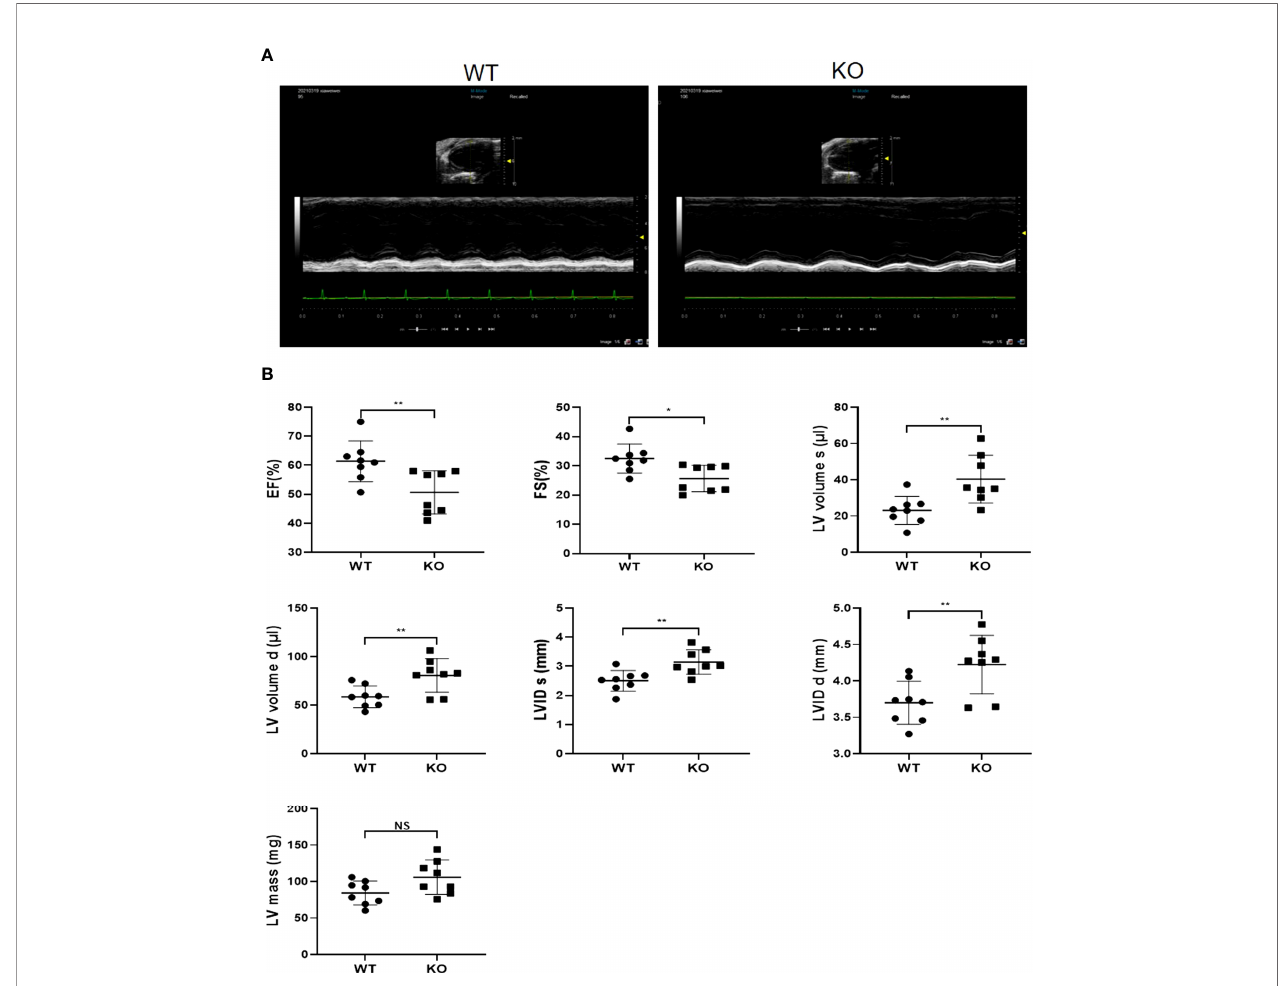
FIGURE 6 | MAVS deletion leads to left ventricular dilation and systolic function decrease in female mice. (A) , Representative short axis M-mode echocardiographic images of female WT and MAVS -/- mice at the age of 6 months. (B) , EF, FS, LVVs/d, LVIDs/d, and LV mass of mice in WT and MAVS -/- mice. The quantitative results were shown as the means ± SEM (NS not signi fi cant, *p < 0.05 and **p <